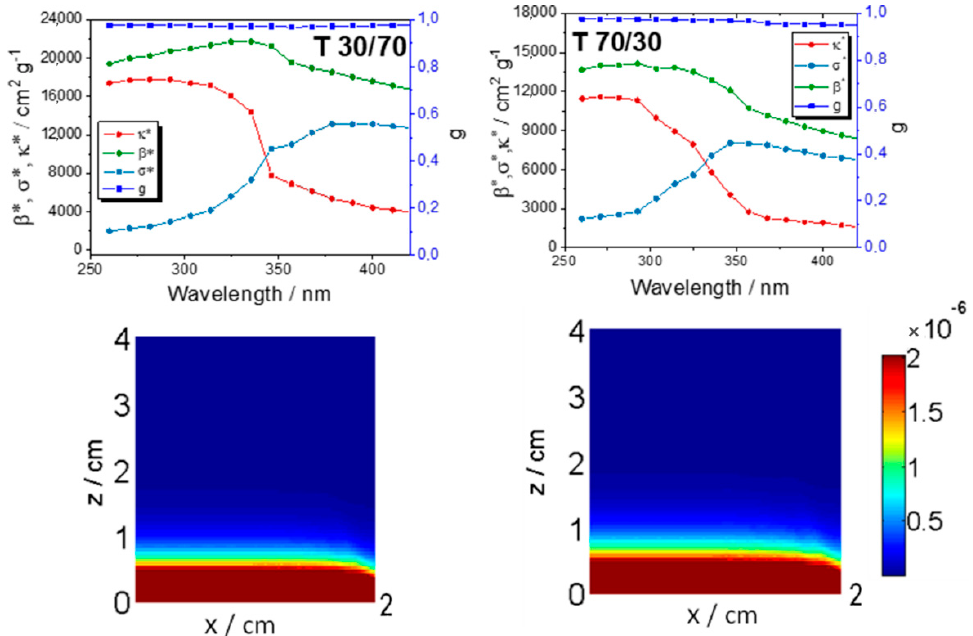
Figure 1. T sample optical properties and volumetric rate of photon absorption (Einstein cm − 3 s − 1 ) for lean and rich methanol mixtures.